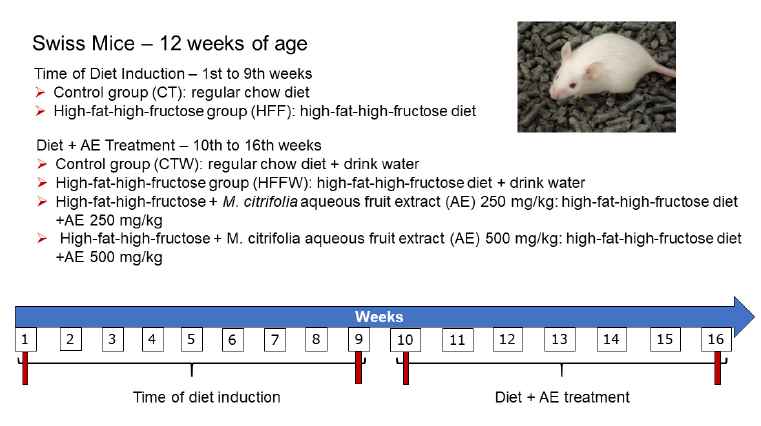
Figure 1. Schematic figure of the experimental design to assess the time of diet induction (from the